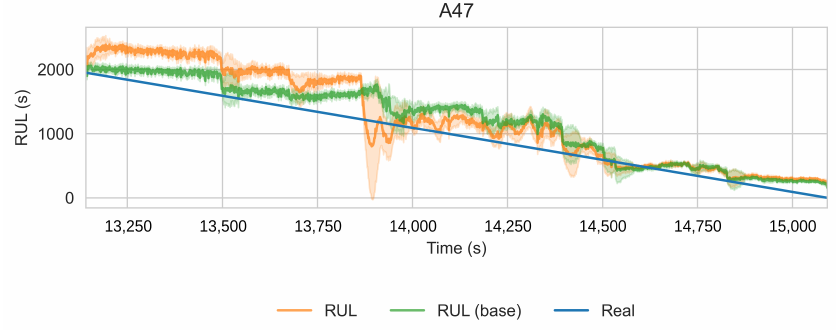
Figure 20. RUL estimation for bearing A47. Comparing the benchmark (green) and the proposed method. Intervals as the +/ − 1 running standard